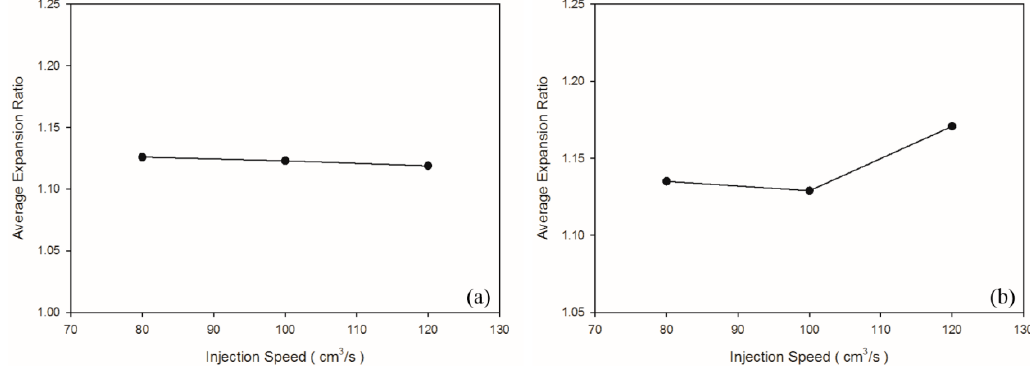
Figure 7. Expansion ratios at various injection speeds: ( a ) PP matrix and AC CBA; ( b ) PS matrix and AC CBA. Table 5. Microscopic effects of injection speed on the PP and PS cells as observed through the SEM.